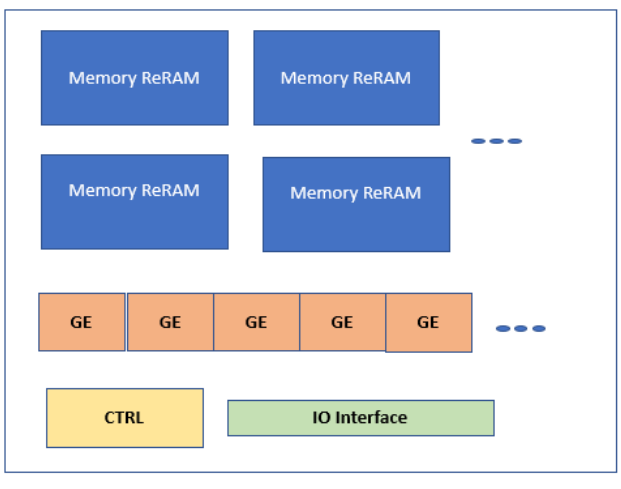
Figure 27. Block description of GraphR architecture proposed in [29].